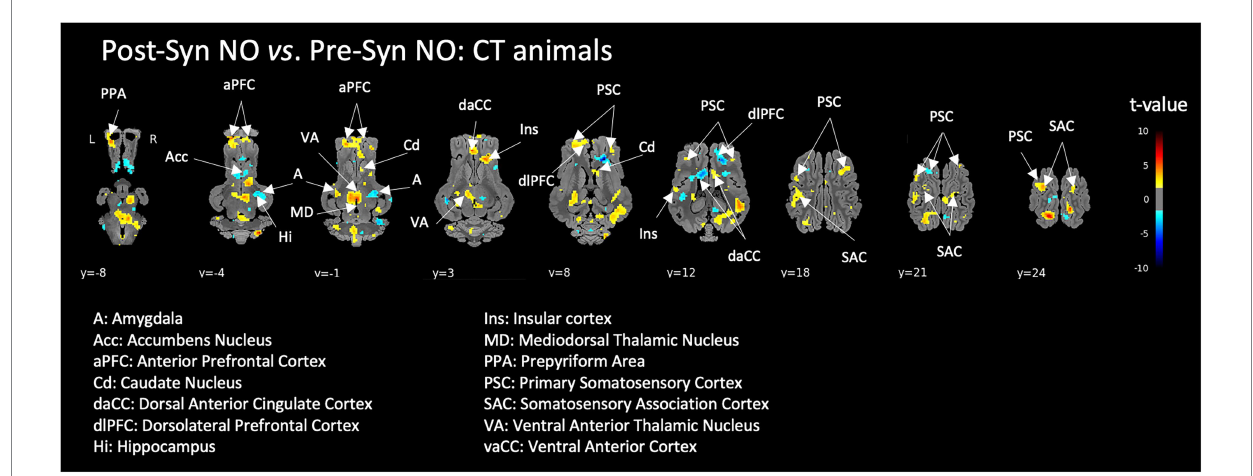
FIGURE 5 Brain responses of control animals (CT) to the induction of a pharmacological acute stress (injection of Synacthen®), corresponding to the contrast ‘after – before’ injection (i.e., Post-Syn – Pre-Syn). BOLD responses during the stimulation with non-odorized air (NO) were used for this comparison. Horizontal maps of brain BOLD responses are represented at different dorsal-ventral levels (y) related to the posterior commissure (in mm). Value of p threshold = 0.05, k > 20 (number of voxels per cluster).